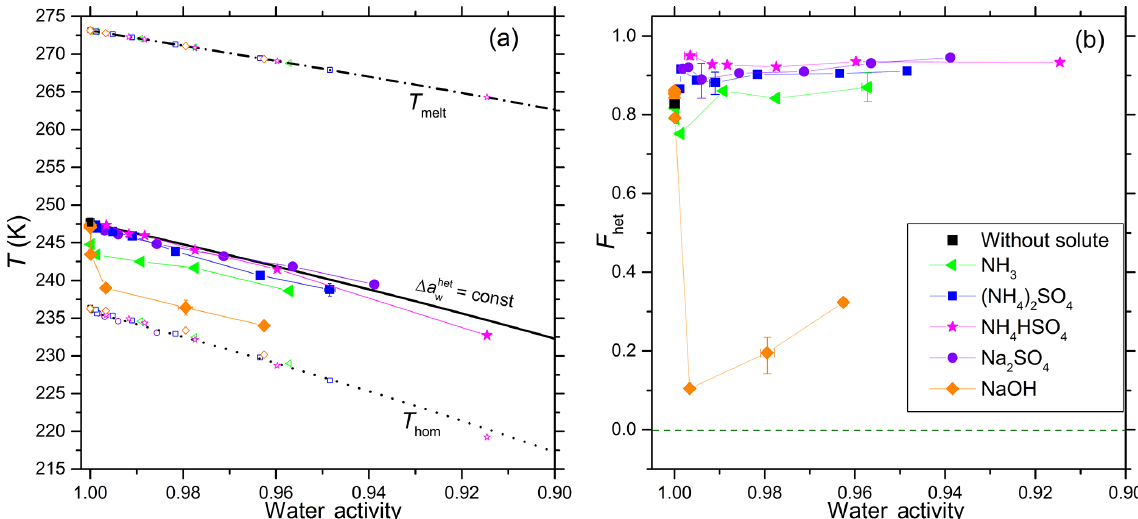
Figure 2. (a) Onset freezing temperatures of emulsion freezing experiments performed with 5wt% SA quartz suspended in aqueous solutions of inorganic solutes (for symbols and colors see insert). Heterogeneous freezing onset temperatures, T het (filled solid symbols connected by thin lines); homogeneous freezing onset temperatures, T hom (open symbols at T < 237K), and ice melting temperatures, T melt (open symbols at T > 262K) are given as functions of the solution’s water activity, a w . Dash-dotted black line: ice melting curve. Dotted black line: homogeneous ice freezing curve for supercooled aqueous solutions obtained by horizontally shifting the ice melting curve by a constant offset (cid:49)a hom w (T ) = 0 . 30. Solid black line: horizontally shifted from the ice melting curve by (cid:49)a het w (T ) = 0 . 221 derived from the heterogeneous freezing temperature of the suspension of quartz in pure water (filled black square at a w = 1). Symbols are the mean of at least two emulsion freezing experiments (using at least two separate suspensions). Two symbols carry error bars to show representative experimental variations (min to max) in T het and a w . (b) Heterogeneously frozen fraction F het as a function of the solution’s water activity ( a w ). Five symbols carry error bars showing representative experimental variations (min to max) in F het and a w . Absolute uncertainties in F het do not exceed ± 0 .